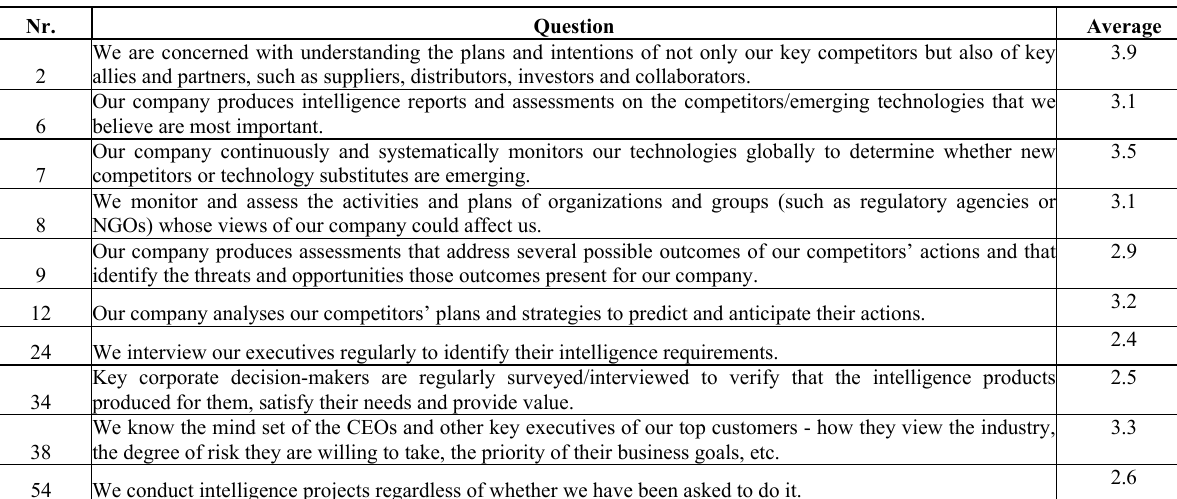
Table 8: Results of planning and focus questions